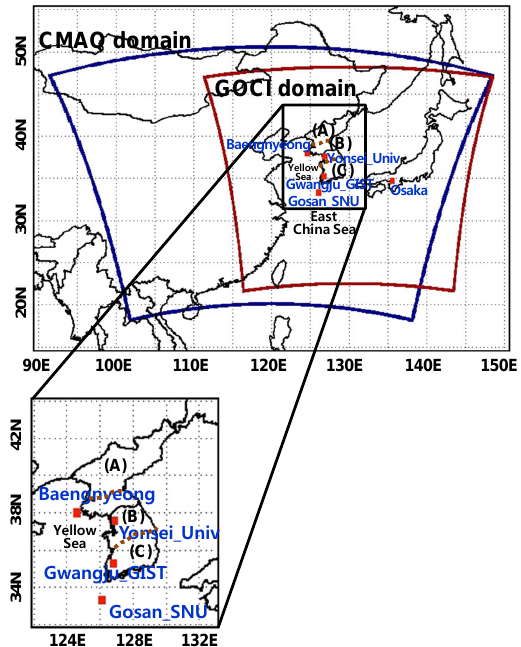
Fig. 1. Domains of CMAQ model simulations (in blue) and COMS/GOCI sensor (in red). Also shown are five AERONET sites in the receptor areas (Korea and Japan). For the sake of analytical convenience, three subregions (A), (B), and (C) in the Korean peninsula are defined; these represent the northern, central, and southern parts of the Korean peninsula, respectively.